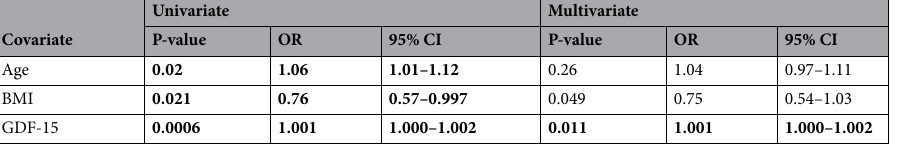
Table 6. Factors associated with a low SMI among male CD patients. Data were analyzed using a univariate analysis and multivariate analysis and adjusted by a logistic regression analysis. BMI body mass index, GDF-15 growth differentiation factor-15, OR odds ratio, CI confidence interval, CD Crohn’s disease. Significant values are in bold.